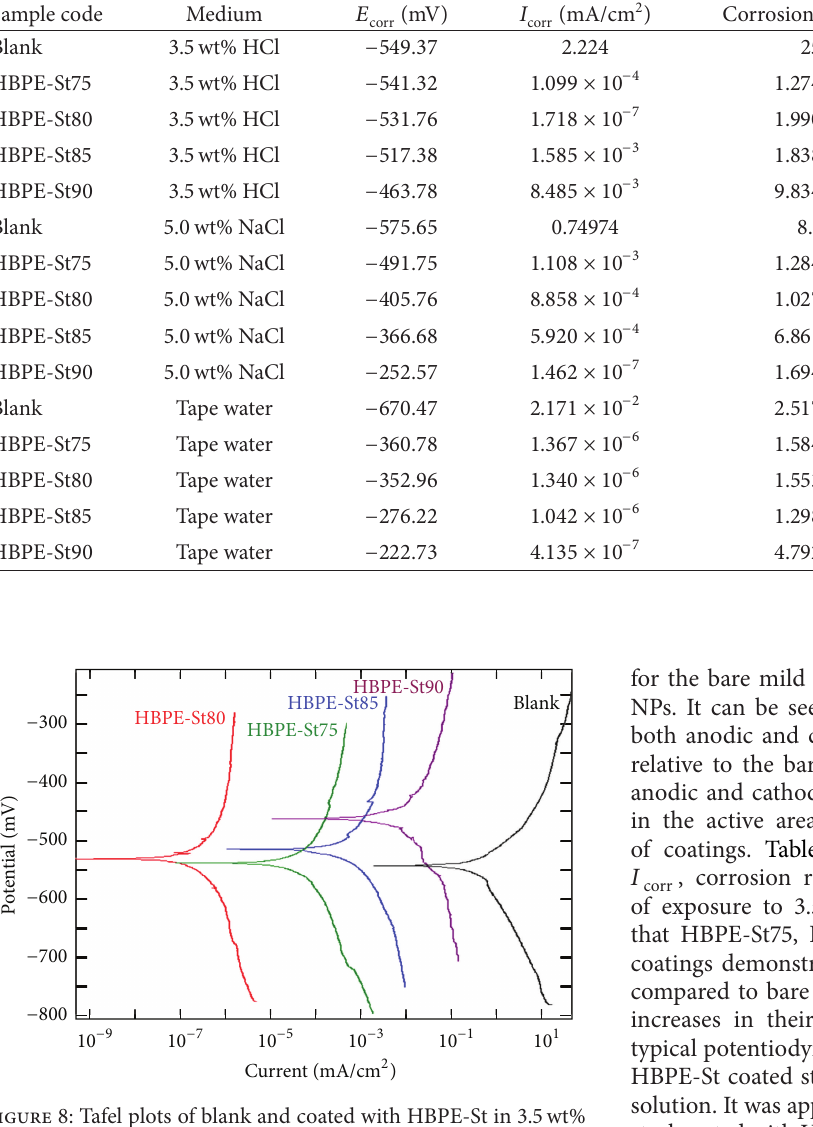
Figure 8: Tafel plots of blank and coated with HBPE-St in 3.5 wt% HCl